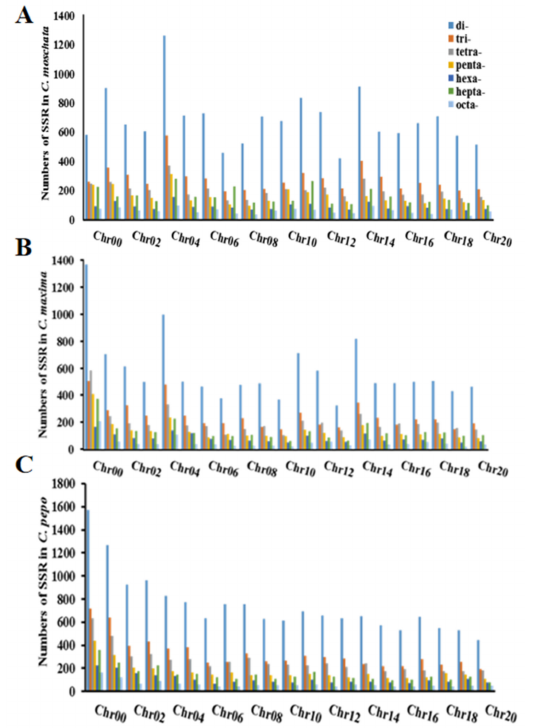
Figure 2. ( A ) The distribution of SSR repeat types on each chromosome in C. moschata . ( B ) The distribution of SSR repeat types on each chromosome in C. maxima . ( C ) The distribution of SSR repeat types on each chromosome in C. pepo . The vertical axis shows the number of microsatellites from di-nucleotide to octo-nucleotide which are discriminated by different colors. The horizontal axis shows different chromosomes of C. ssp , and LG00 means all the chromosome unanchored